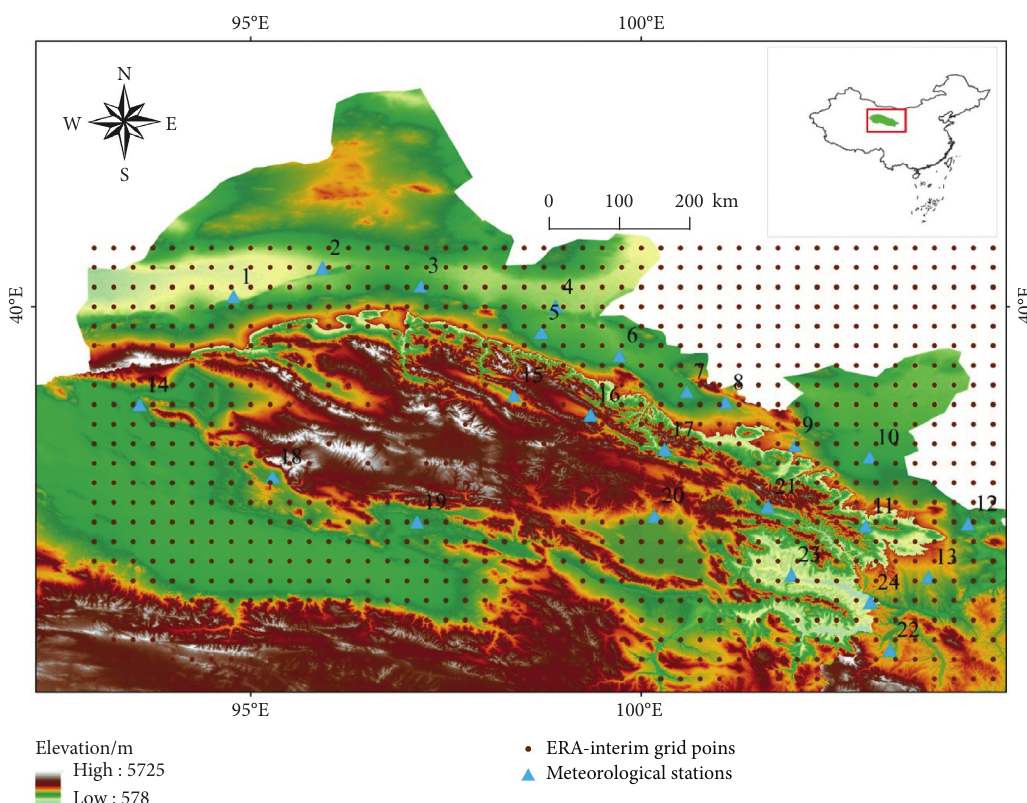
Figure 1: Locations of the 24 meteorological stations (yellow triangles) and ERA-Interim 0.25 ° × 0.25 ° grid points (dots) in QLM. The numbers refer to the stations shown in Table